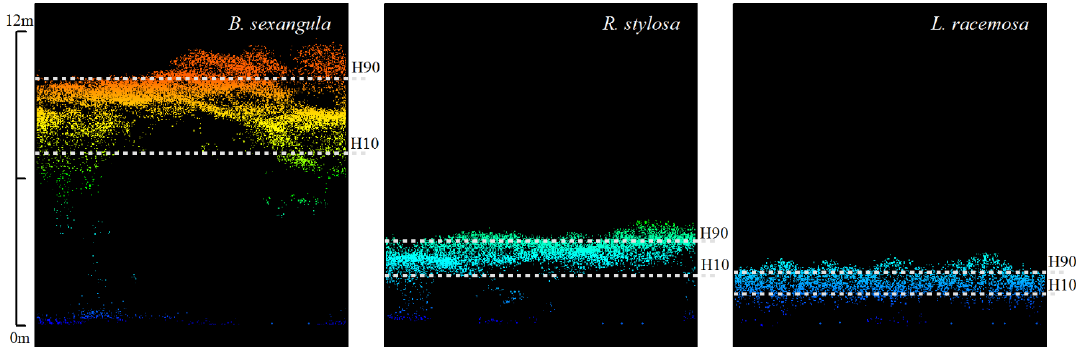
Figure 11. Illustrations of UAV-LiDAR point cloud profiles of B. sexangula (left), R. stylosa (center) , and L. racemosa (right).